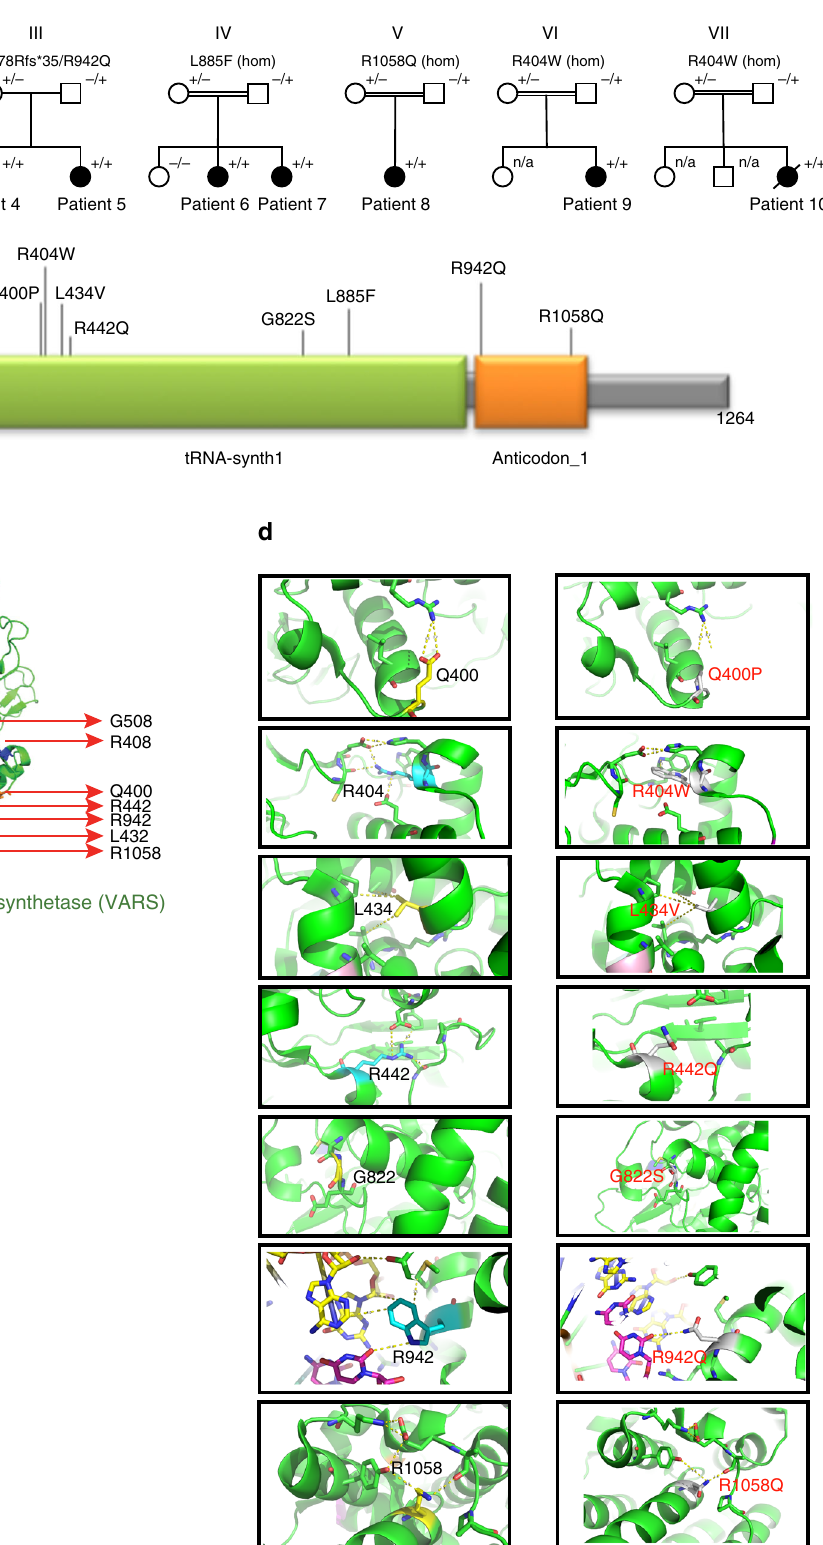
Fig. 1 Identi fi cation of VARS variants in seven families with developmental encephalophaties and in silico predictions. a Pedigrees of the seven families diagnosed with VARS mutations. b Location of the identi fi ed VARS variants on protein level (InterPro/P26640). c Ribbon cartoon model of the Thermus thermophilus VARS-tRNA complex, highlighting the residues corresponding to those substituted in the human model. d Pair-wise comparisons between the wild-type (left) and mutant (right) residues for predicted changes in local contacts with tRNA or other amino acids. Hydrogen bonds were indicated as dotted yellow